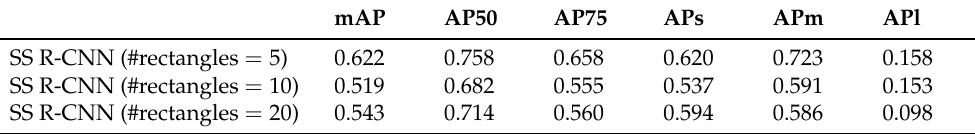
Table 7. Effect of the number of rectangles in more-way CutPaste operation for SS R-CNN. mAP AP50 AP75 APs APm APl SS R-CNN (#rectangles =